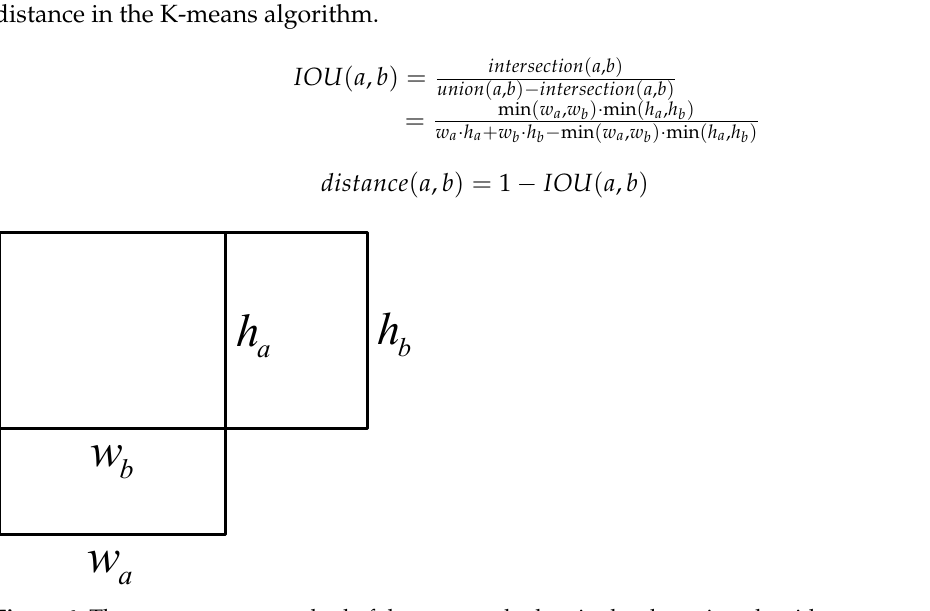
Figure 6. The measurement method of the rectangular box in the clustering algorithm.